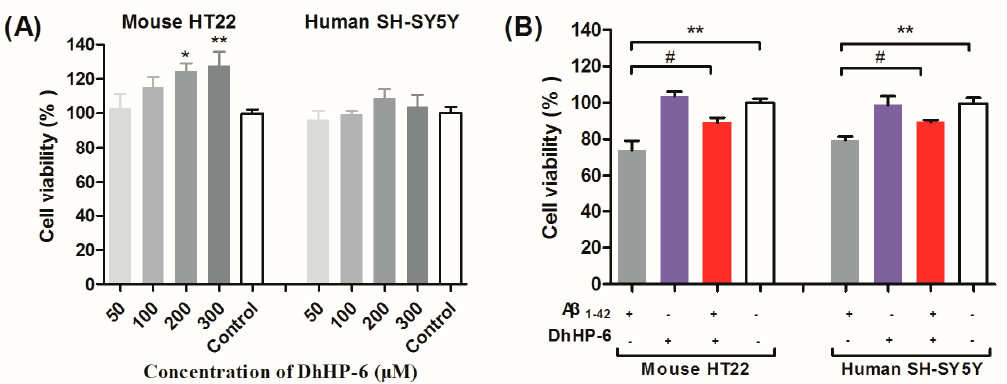
Figure 2. Cytotoxicity of DhHP-6 and its neuro-protective effect on A β 1-42 treated SH-SY5Y human neuroblastoma and HT22 mouse hippocampal neuron cell lines. ( A ) DhHP-6 promoted the proliferation of HT22 cells (* p = 0.0226, ** p = 0.0036) at 200 µ M and 300 µ M, but had no effect on SH-SY5Y cells at 50 µ M, 100 µ M, 200 µ M, and 300 µ M. ( B ) A β 1-42 oligomers (30 µ M) showed significant cytotoxicity in both HT22 and SH-SY5Y cells, and 100- µ M DhHP-6 protected cells from A β 1-42-induced cytotoxicity (** p < 0.01; # p < 0.05).